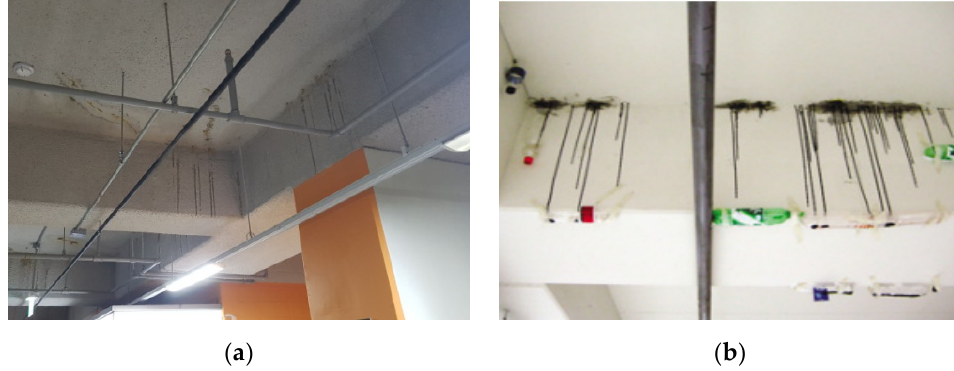
Figure 1. Oil leakage phenomenon and contamination status in underground parking lots: ( a ) oil leakage from slab in underground parking lot; ( b ) oil leakage from slab in underground parking lot.